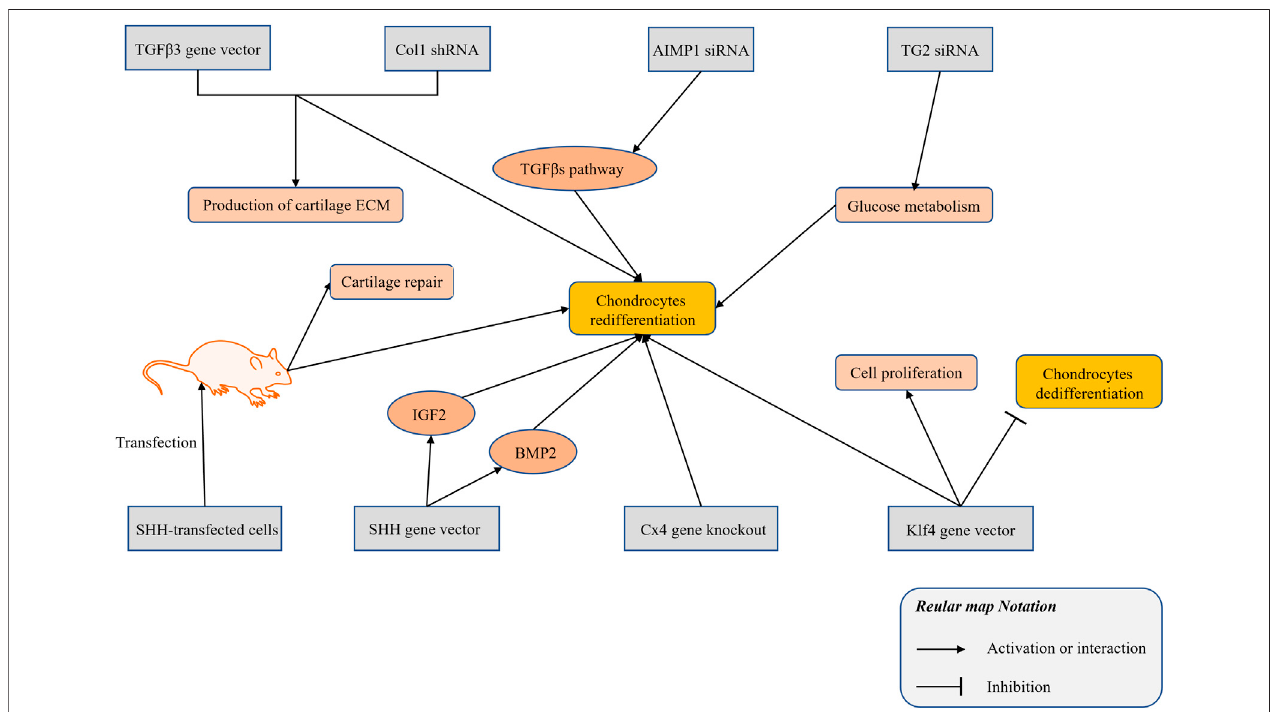
FIGURE 3 | The research progress of gene silencing and expression technology in modulating the chondrocytes redifferentiation.